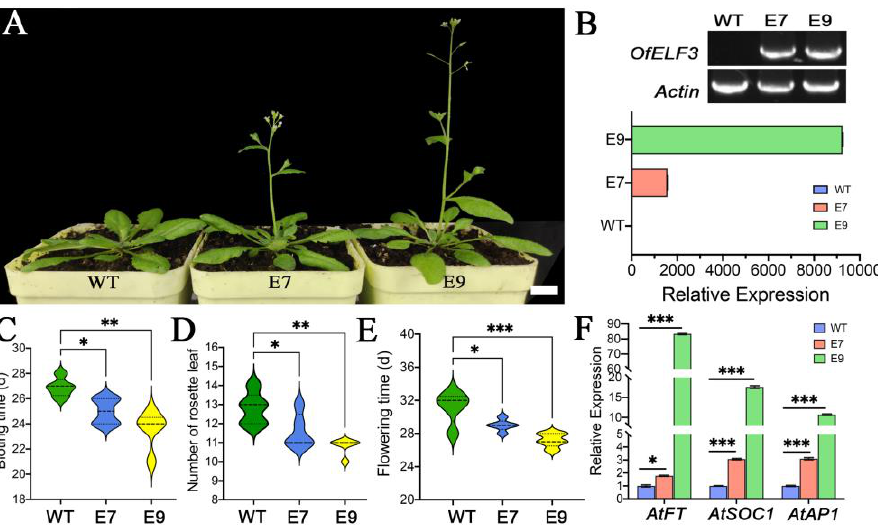
Figure 4. Overexpression of OfELF3 promotes flowering in A. thaliana . ( A ) Phenotype of transgenetic lines. Scale bars = 1 cm. ( B ) Identification of OfELF3 transgenic lines by PCR and qRT-PCR analysis. ( C – E ) The investigation of bolting time, number of rosette leaves, and flowering time in lines E7 and E9. ( F ) Expression analysis of AtFT , AtAP1 , and AtSOC1 in lines E7 and E9. The error bars indicate the SD values from at least three repeats of each treatment. * p < 0.05, ** p < 0.01, *** p < 0.001, t